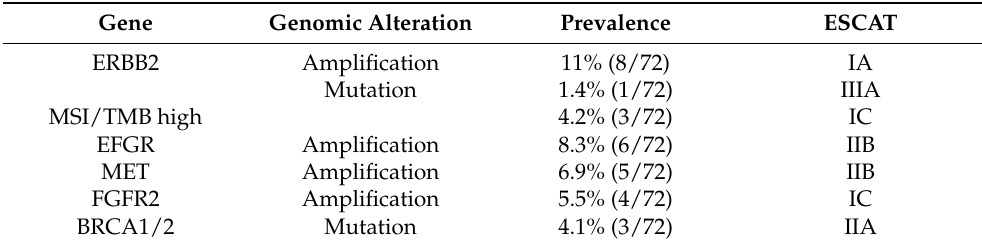
Table 3. The ESMO classification of the alterations of various genes and their therapeutic relevance by ESCAT level. Table adapted from [14]. Gene Genomic